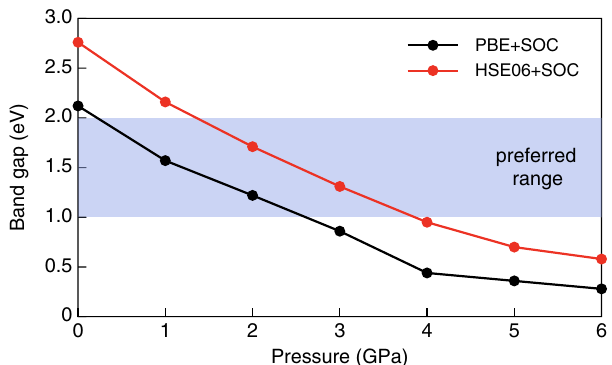
Fig. 6 Band gap of R3m 3D-cubic N(CH 3 ) 4 SnI 3 as a function of external hydrostatic pressure. Black line: calculated using PBE + SOC, red line: calculated using HSE06 + SOC. The blue color shows the band gap range suitable for the light-absorber semiconductor in solar